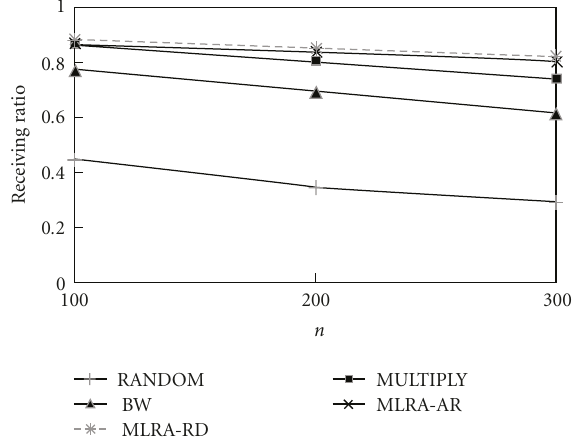
Figure 6: Receiving ratio versus n with varying n . Other parameters are listed in Table 1.